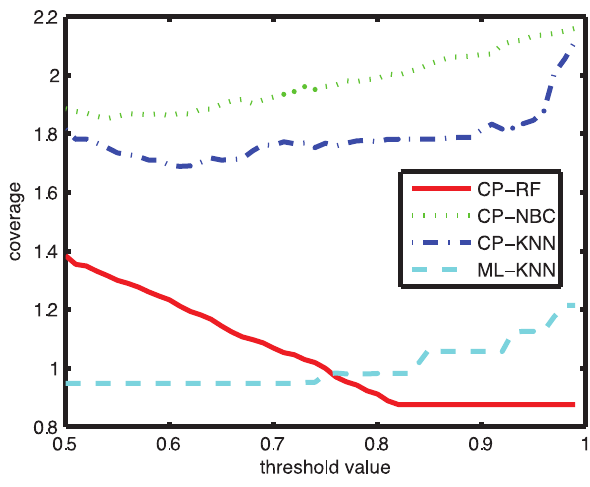
Figure 5. Comparison of one-error with different thresholds.